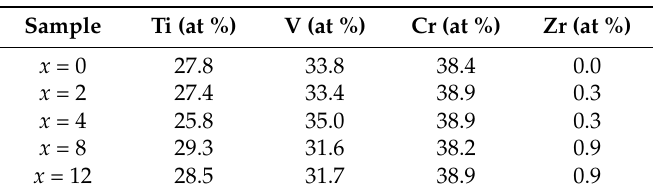
Table 2. EDX analysis showing the elemental composition of the matrix (point 1) of: Ti 1 V 0.9 Cr 1.1 + x wt % Zr alloys for x = 0, 2, 4, 8, and 12.